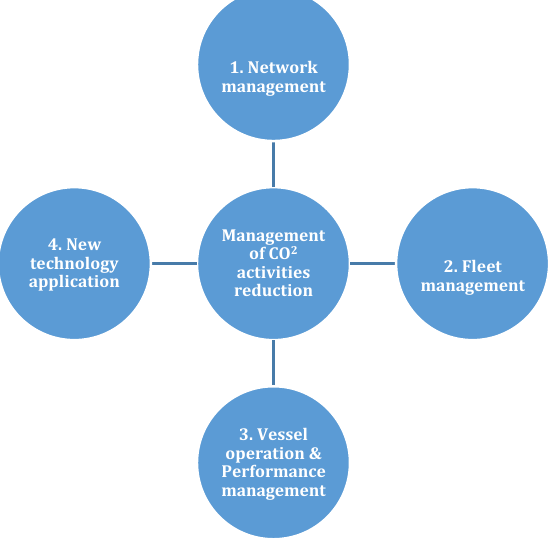
Figure 2: CO 2 reduction ecomanagement activities applied by Hanjin